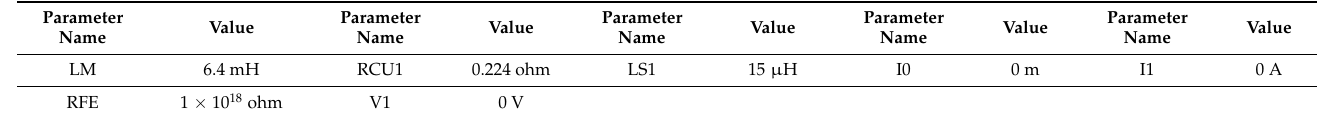
Table A5. Electrical parameters of the transformer, primary side—TFR1P1_n from Figure 6.